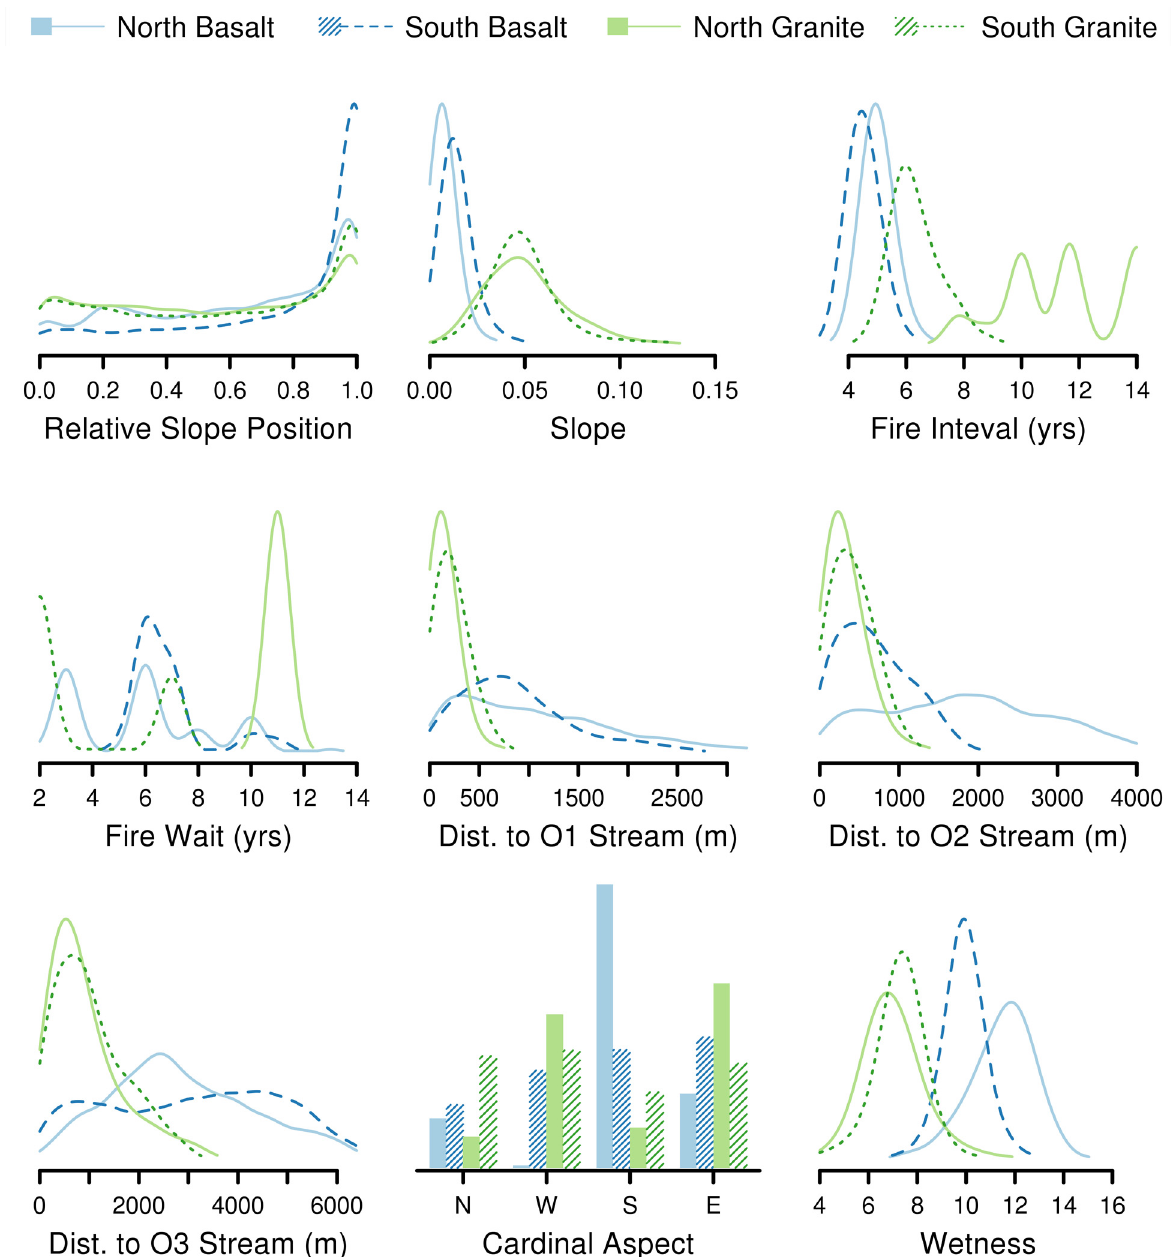
Fig 3. Distributions of the environmental factors by watershed. Probability density functions of environmental drivers of woody vegetation cover showing the large differences between watersheds. The distributions are computed using a Gaussian kernel on 5000 randomly located samples selected from each watershed (without stratification), and they are scaled to fit all four watersheds on a single plot. The abbreviations O1, O2 and O3 refer to order 1, 2 and 3 streams,